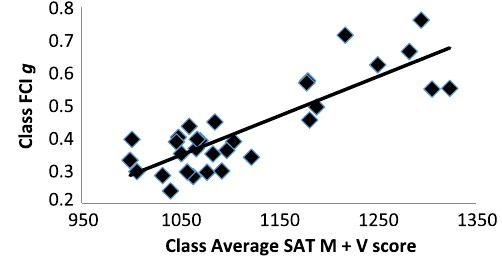
FIG. 2. Class average data for 31 classes at Edward Little High School with a total of 361 students ( r ¼ 0 . 84